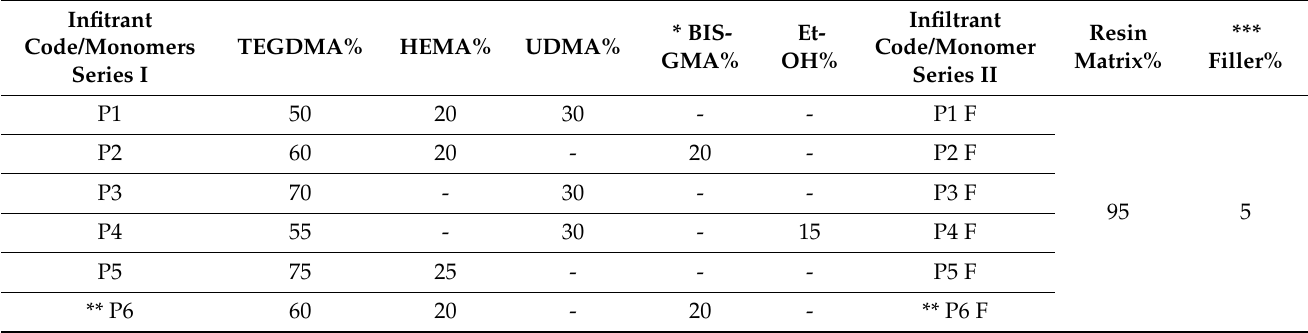
Table 1. The composition of experimental resin